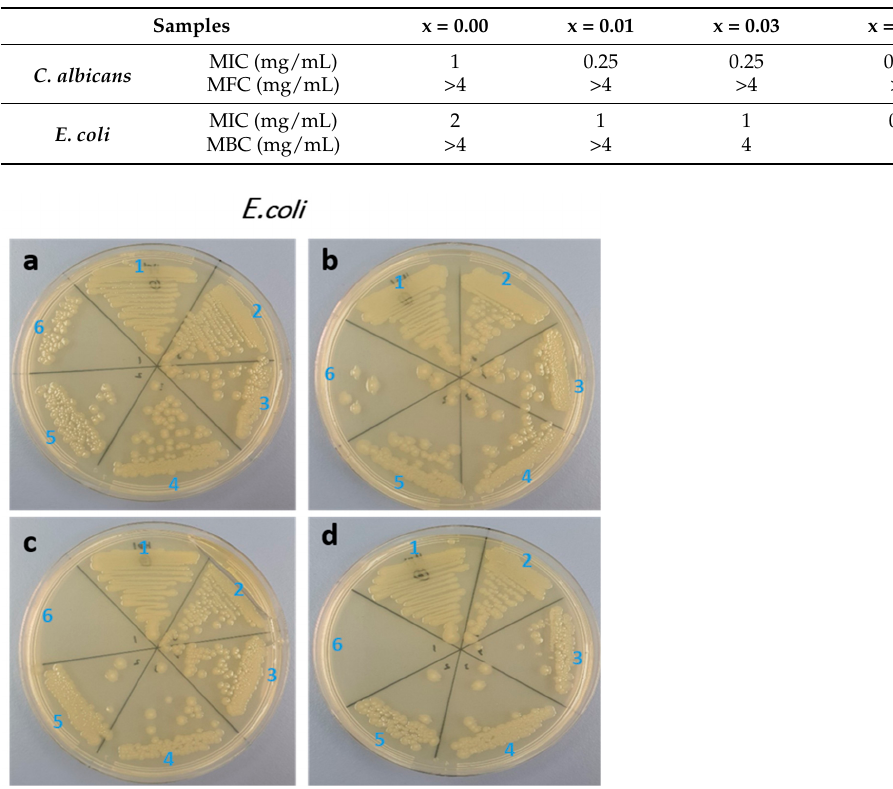
Figure 6. Agar plates showing the MIC/MBC of E.Coli upon treatment with Yb and Ce co-doped ZnO NPs (x = 0.00, x = 0.01, x = 0.03, x = 0.05), (( a ): x = 0.00, ( b ): x = 0.01, ( c ): x = 0.03, ( d ): x = 0.05), (1: untreated; 2: 0.25; 3: 0.5; 4: 1; 5: 2; 6: